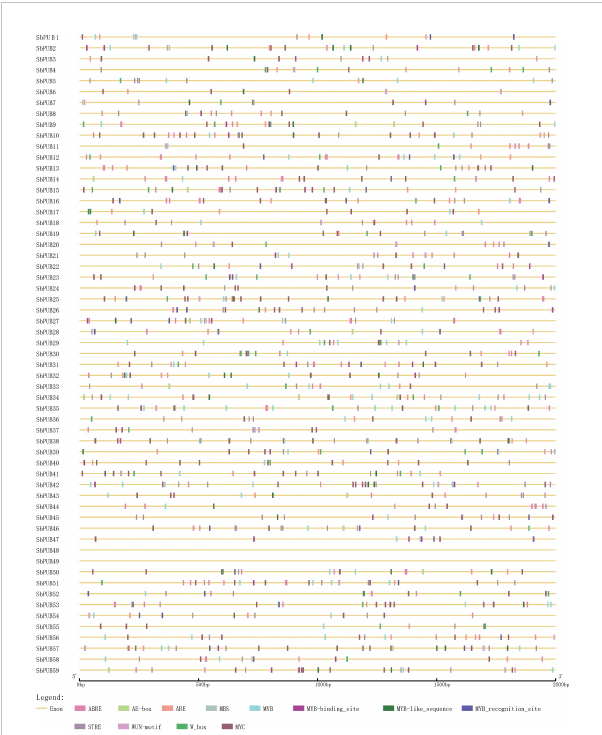
FIGURE 4 The cis -acting elements analysis of the putative promoter of 59 SbPUB genes. The distribution pattern of 12 elements of the putative promoter of the PUB gene family in sorghum, which function was related to salt stress. The color scale at the bottom represents these cis-acting elements, especially MYB-related elements, which were considered to involve in fl avonoid biosynthetic genes